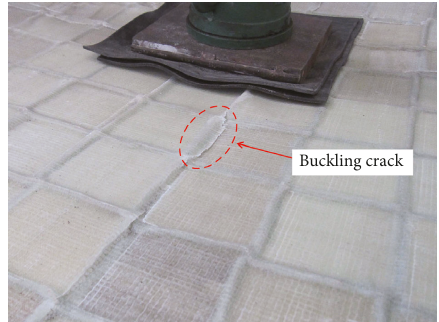
Figure 7: Failure mode of specimen TS75-75.